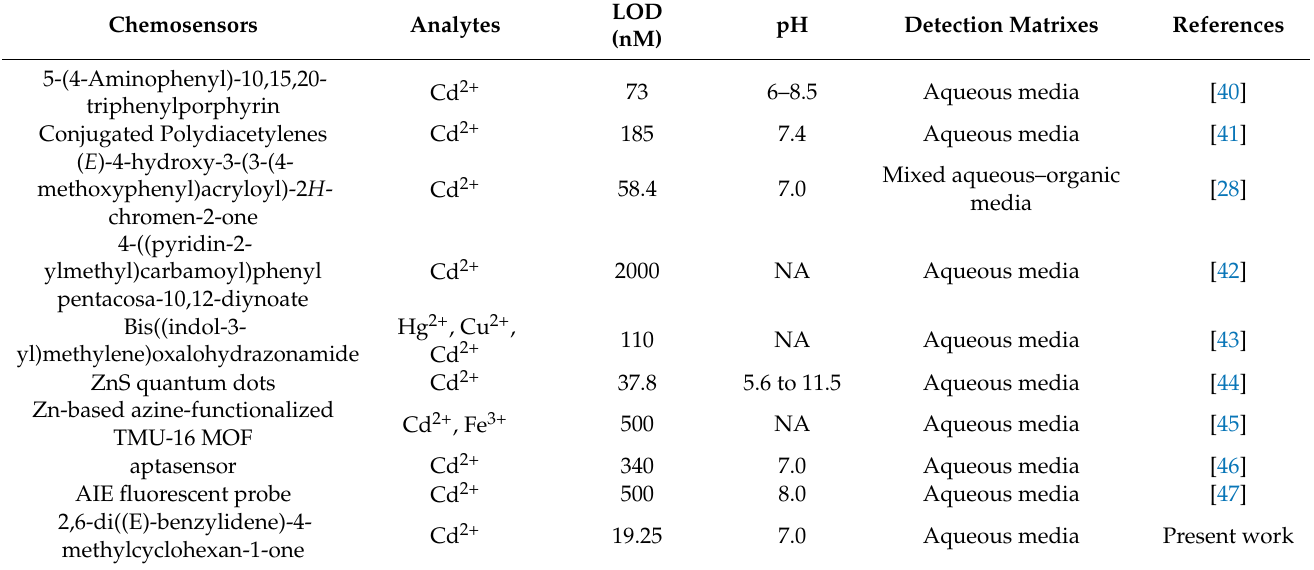
Table 3. Comparison of sensitivity (LOD) of CM1 with other reported